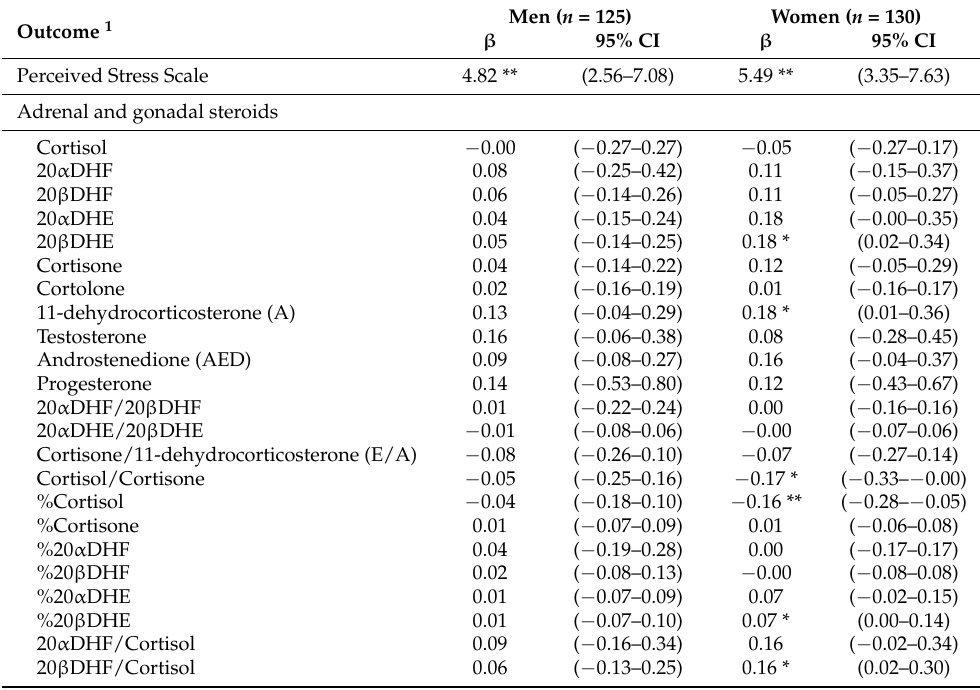
Table 2. Linear regression coefficients and 95% confidence intervals (CI) for EPRES global scale predicting Production of Adrenal and Gonadal steroids and PSS, adjusted for control variables and stratified by sex. Precarious Employment and Stress Study sample,